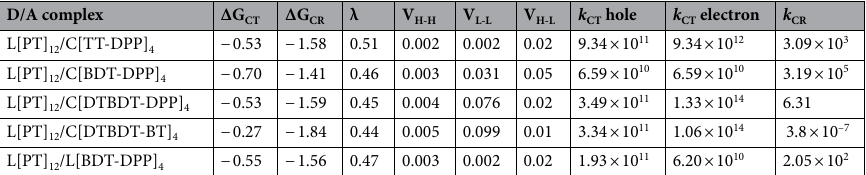
Table 7. Calculated free energy change of charge transfer ΔG CT (eV) and charge recombination ΔG CR (eV), reorganization energy λ (eV), transfer integrals HOMO–HOMO coupling V H-H (eV), LUMO–LUMO coupling V L-L (eV), HOMO–LUMO coupling V H-L (eV), rate of charge transfer ( k CT ) and charge recombination ( k CR ) in S −1 mPW1PW91/6-31G** level of